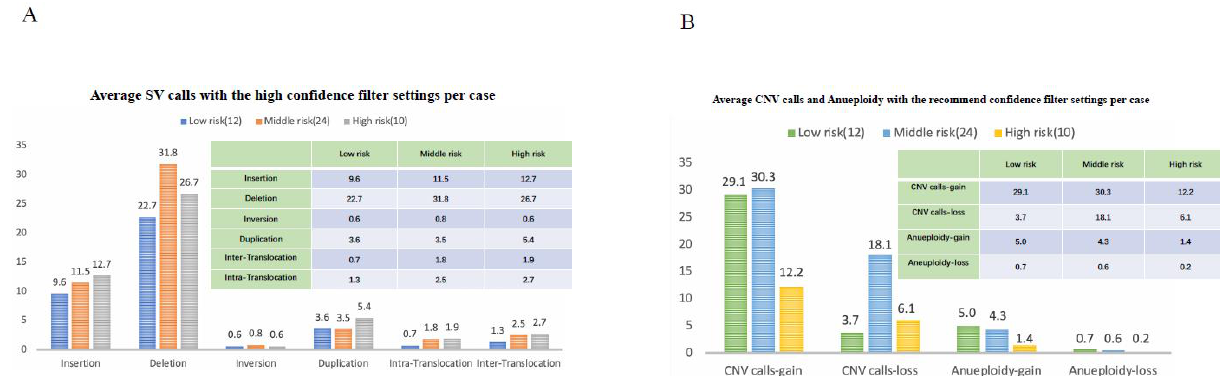
Figure 6. Chromosomal aberrations in 46 samples, analyzed by rare variant analysis using DLS marker. ( A ) Average SV with high filter settings per case. Different color bars represent different risk groups. The x axis showed different SV types, including insertion, missing, inversion, repetition, and translocation. The y axis showed the number of cases. ( B ) Average CNV and aneuploidy, with the recommended filter settings per case. The x axis showed the gain and loss of copy numbers and aneuploidy, while the y axis corresponded to the number of cases.